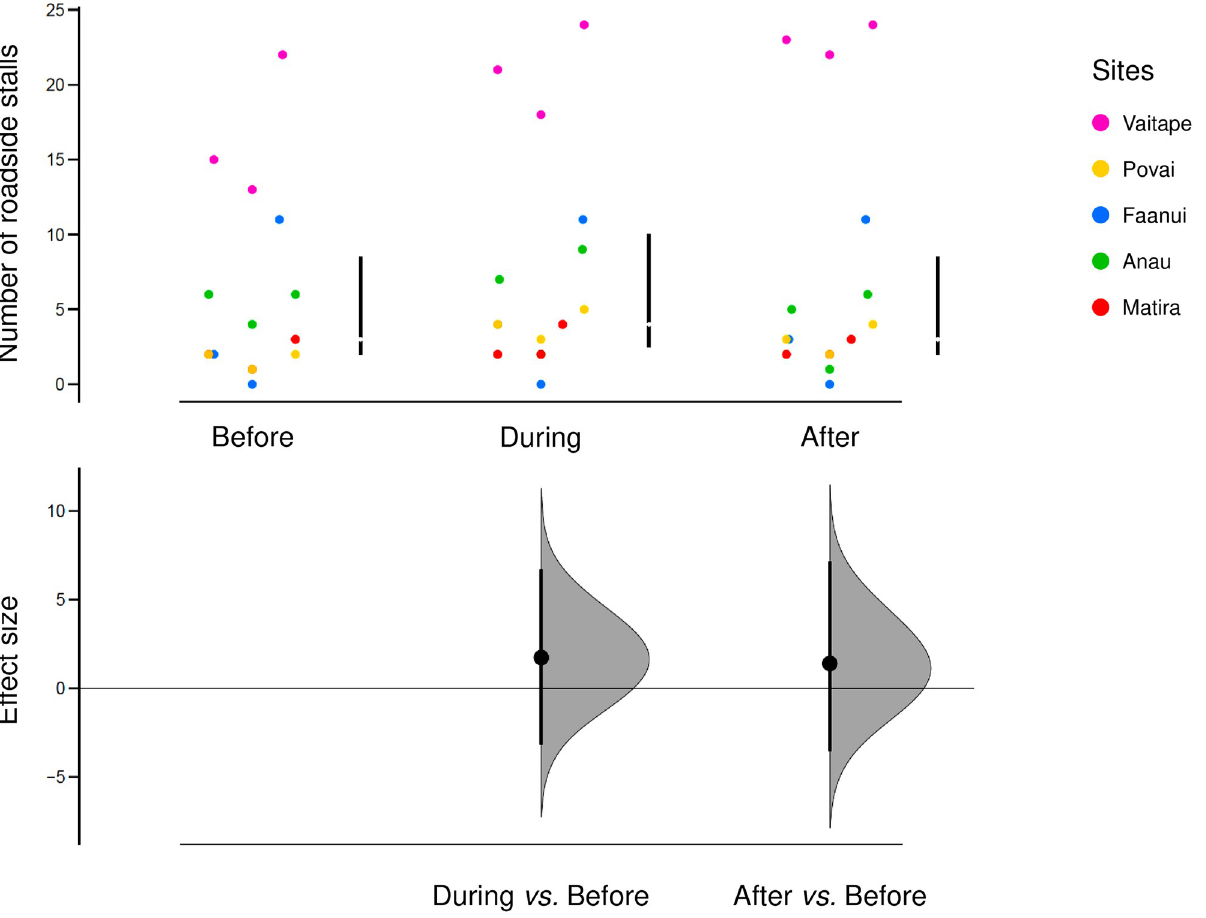
Fig 2. Cumming estimation plot of the number of roadside stalls in Bora-Bora. Top: Raw data per site with vertical bars representing the median (gap in the line) and 25th and 75th percentiles of each period. Bottom: Effect sizes measured as the paired mean differences (circle) ± 95% CIs (vertical bars). Sampling distributions are displayed in